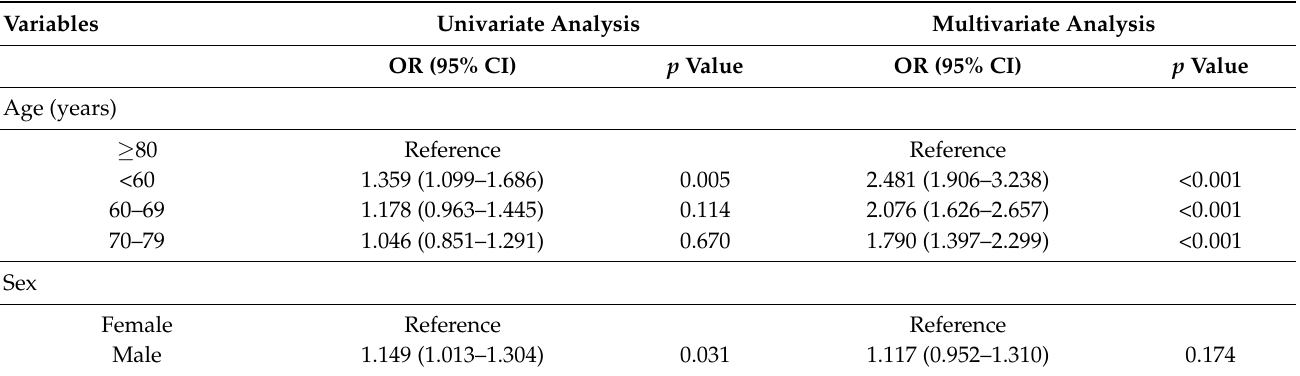
Figure 2. ( A ) The lasso regression is used to find the optimal lambda value. ( B ) Results of 10 ‐ fold cross ‐ validation. Table 2. Univariate and multivariate logistic regression analyses for risk factors associated with distant metastasis of